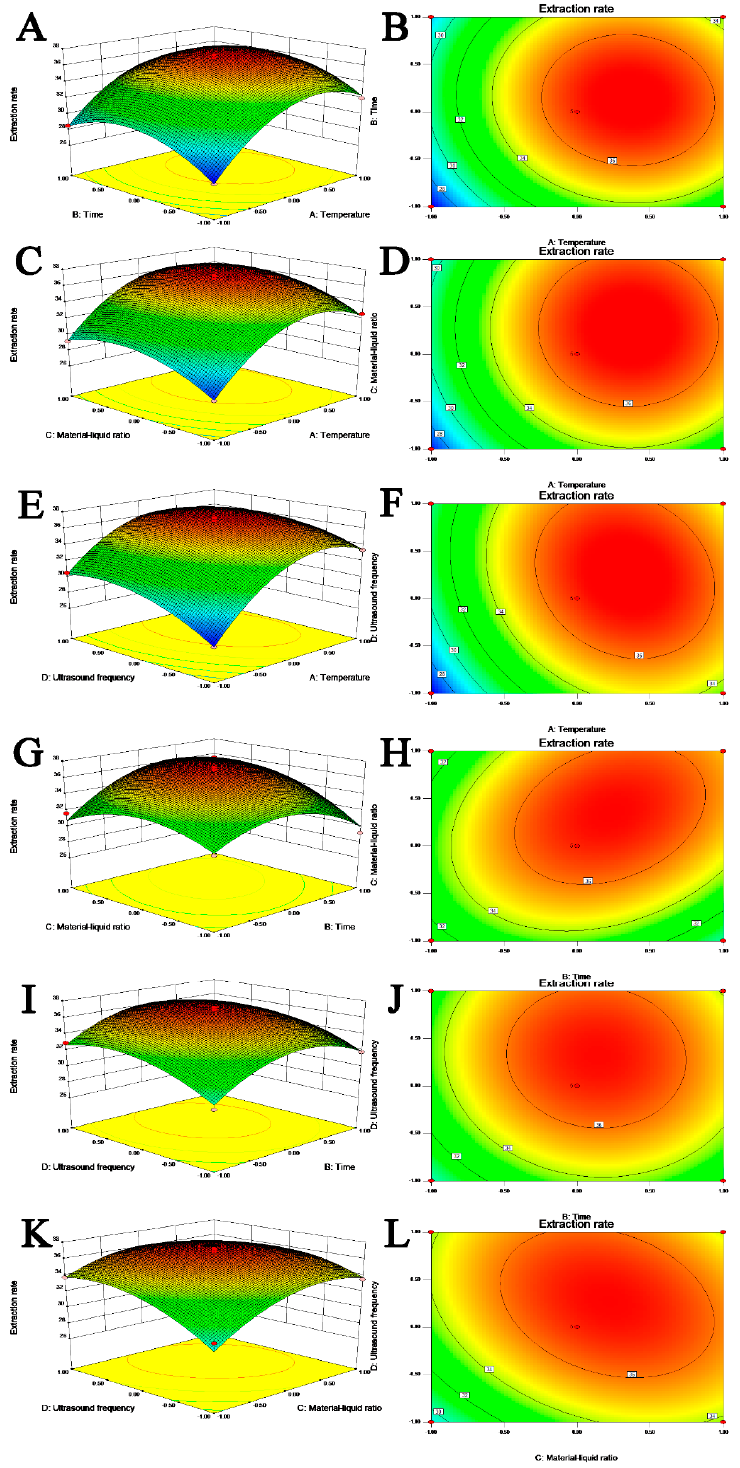
Figure 3. 3D response surface plots ( A , C , E , G , I , K ) and contour plots ( B , D , F , H , J , L ) showing the interaction effects on the naringin extraction yield; ( A , B ), extraction temperature and extraction time; ( C , D ), extraction temperature and material liquid ratio; ( E , F ), extraction temperature and ultrasonic frequency; ( G , H ), extraction time and material liquid ratio; ( I , J ), extraction time and ultrasonic frequency; ( K , L ), material liquid ratio and ultrasonic